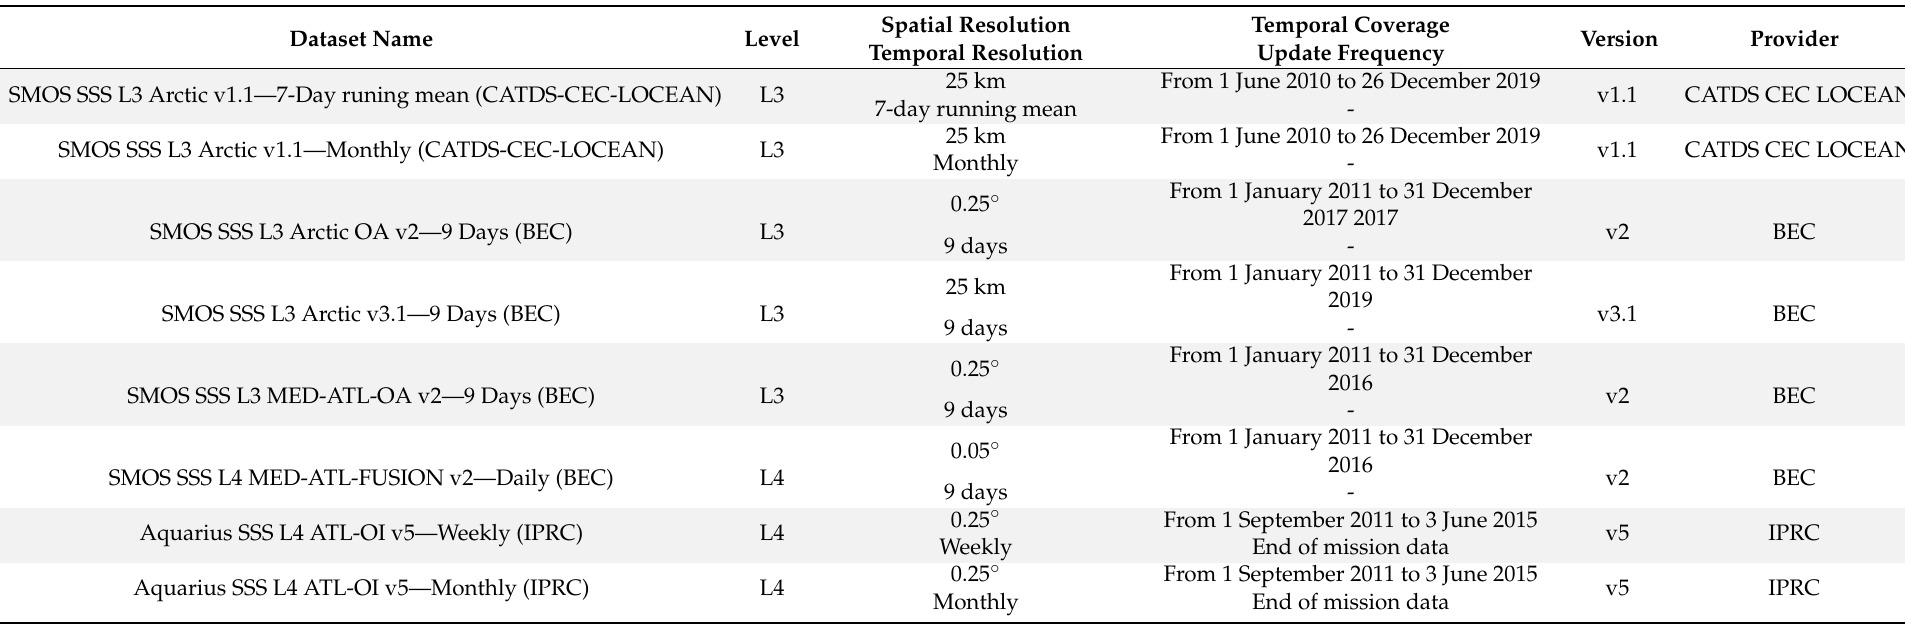
Table 3. List of regional satellite SSS products available in Pi-MEP (15 September